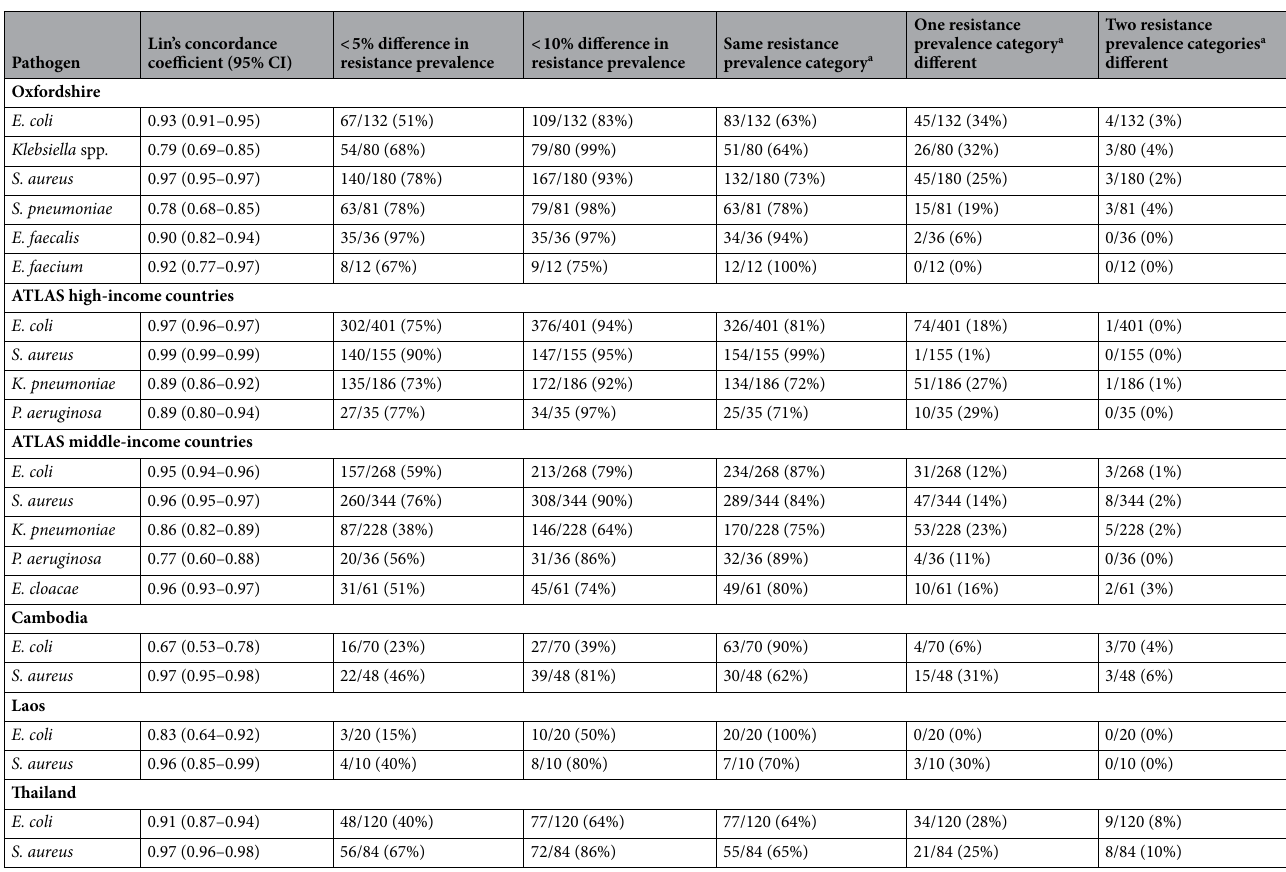
Table 1. Resistance prevalence in blood and non-blood cultures across drug-years, Oxfordshire 1998–2018. a Resistance prevalence categories are: < 5%, 5–10%, 10–20%, > 20%. In the Oxfordshire dataset, non-blood cultures are urine for E. coli and Klebsiella spp., other non-sterile sites for S. aureus and all other body sites for other Gram-negatives and S. pneumoniae , E. faecalis and E. faecium ; in the ATLAS dataset non-blood cultures are all other body (i.e. non-blood) sites for all pathogens; in the three hospitals from LMICs non-blood cultures are urine for E. coli and swabs/pus for S.